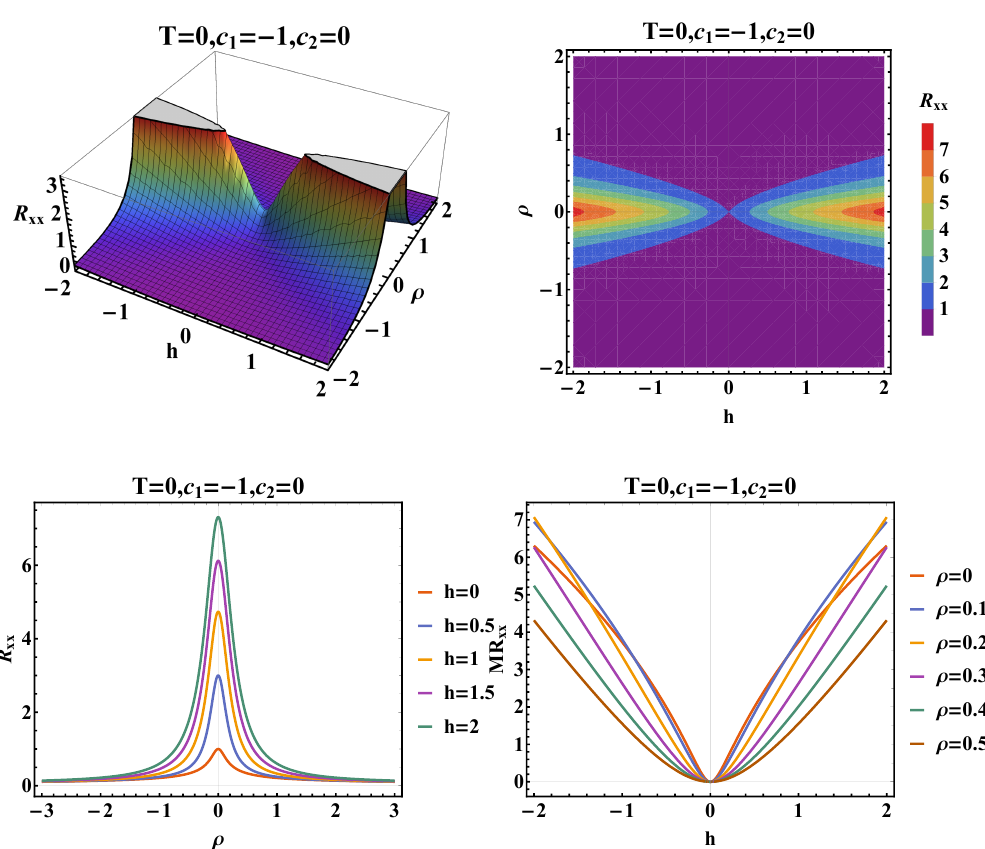
Figure 3 . Upper left: R xx as a function of ρ and h . Upper right: contour plot of R xx . Lower left: R xx vs ρ with h = 0 , 0 . 5 , 1 , 1 . 5 , 2 . Lower right: MR xx vs h with ρ = 0 , 0 . 1 , 0 . 2 , 0 . 3 , 0 . 4 , 0 . 5 . We set T = 0 , c 1 = − 1 , and c 2 = 0